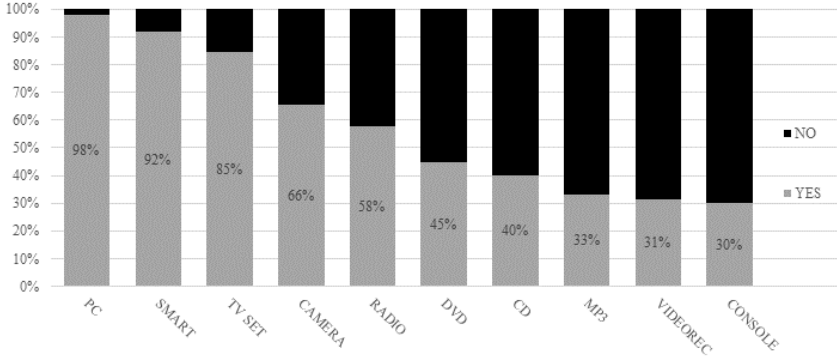
Fig. 1. Students’ technical